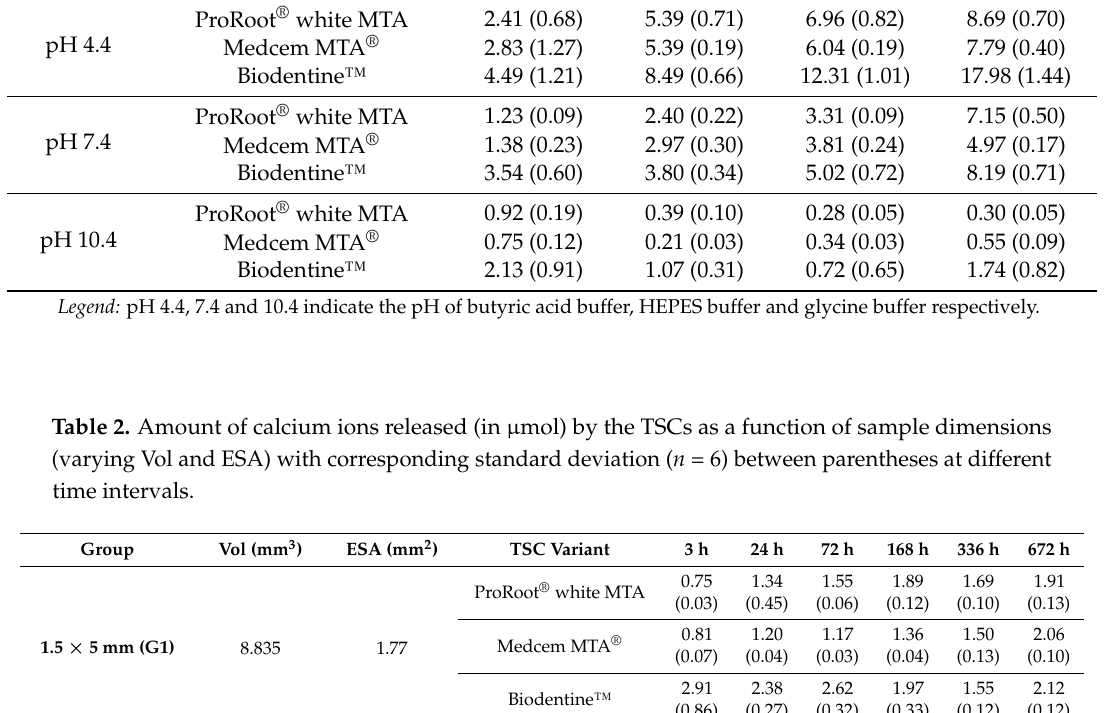
Figure 1. The X-ray diffraction patterns of the powder component of the TSCs studied. Legend: CH: Calcium hydroxide; TCS: Tricalcium silicate; DCS: Dicalcium silicate; CS: Calcium sulphate; ZO: Zirconium oxide; BO: Bismuth oxide; CAO: Calcium aluminium oxide; CC: Calcium carbonate. Table 1. Amount of calcium ions released (in μmol) with corresponding standard deviation ( n = 6) between parentheses of the TSC variants studied as a function of pH at different time intervals. Group